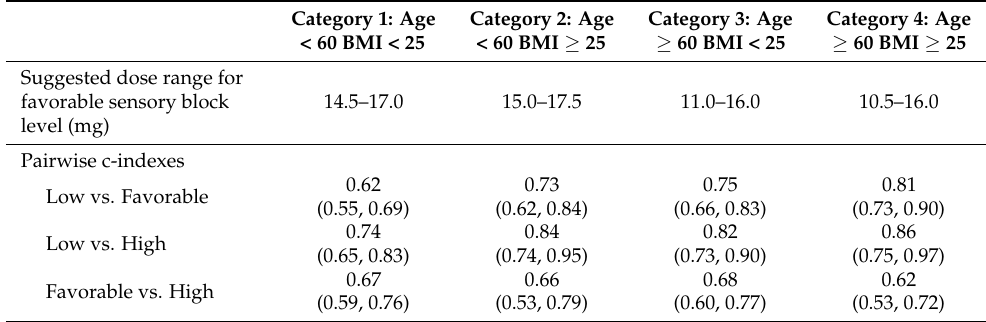
Figure 2. Marginal prediction curves visualizing the association between the isobaric bupivacaine dose and sensory block levels across 4 different categories of patients. The red solid line with square markers represents the predicted probabilities of achieving a favorable spinal block level. The blue solid line with square markers represents the predicted probabilities of achieving a low spinal block level, and the green solid line with square markers represents the predicted probabilities of achieving a high sensory block level after spinal anesthesia. The red upper dash line marks the average incidence rate of high sensory blocks, whereas the red lower dash line marks half the average incidence rate of high sensory blocks. The highlighted light-blue region represents the suggested range of isobaric bupivacaine doses for each subgroup. Table 3. Suggested range of isobaric bupivacaine dosages for each patient category based on the predicted curves of polytomous logistic regression models and their discriminative